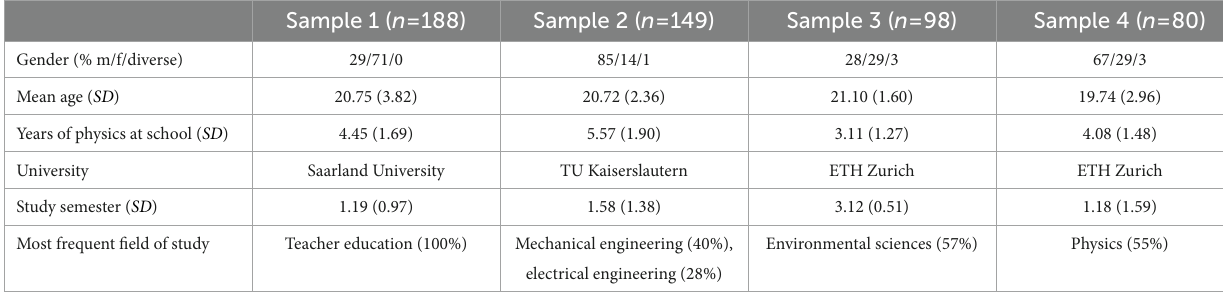
TABLE 1 Characteristics of participants in the four